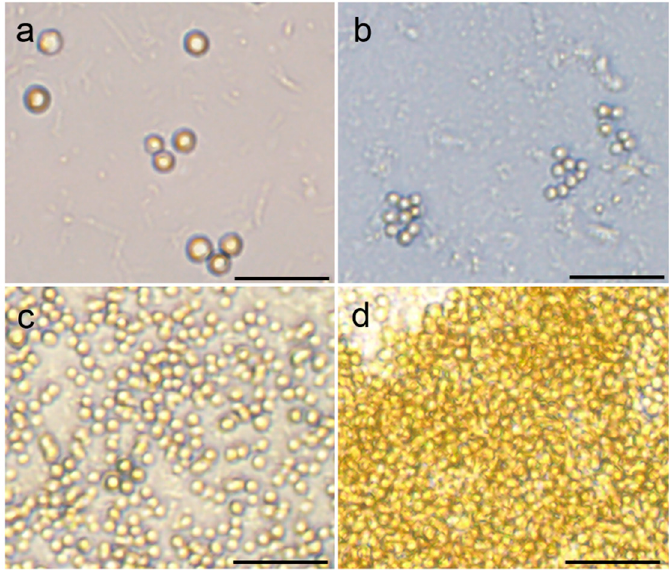
Figure 3. Germination of resting stage cells of A. anophagefferens strain CCMP1984 and subsequent rapid growth. The observations were conducted under the light microscope with the same magnification and sample volume (10 mL). Resting stage cells completely reverted to vegetative cells condition (21 °C) and grew to a very high cell density in ~20 days. ( a ) 0 day, ( b ) 10th day, ( c ) 20th day, ( d ) 30th day. Scale bars = 10 μ